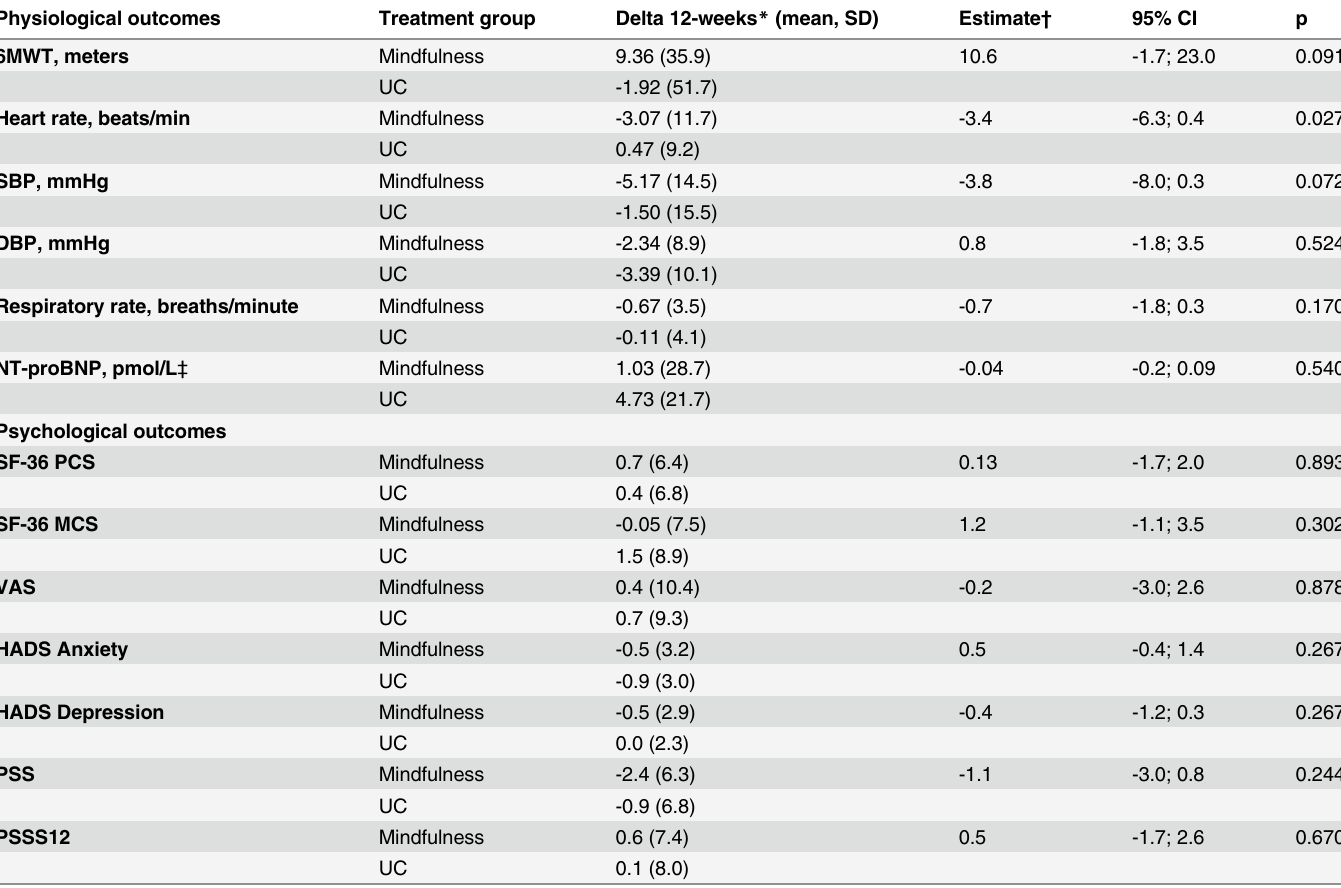
Table 3. Changes in outcomes at 12 weeks compared with baseline (intragroup effect) and differences between treatment groups (intergroup effect) on physiological and psychological outcomes, as-treated analyses. Physiological outcomes Treatment group 6MWT,